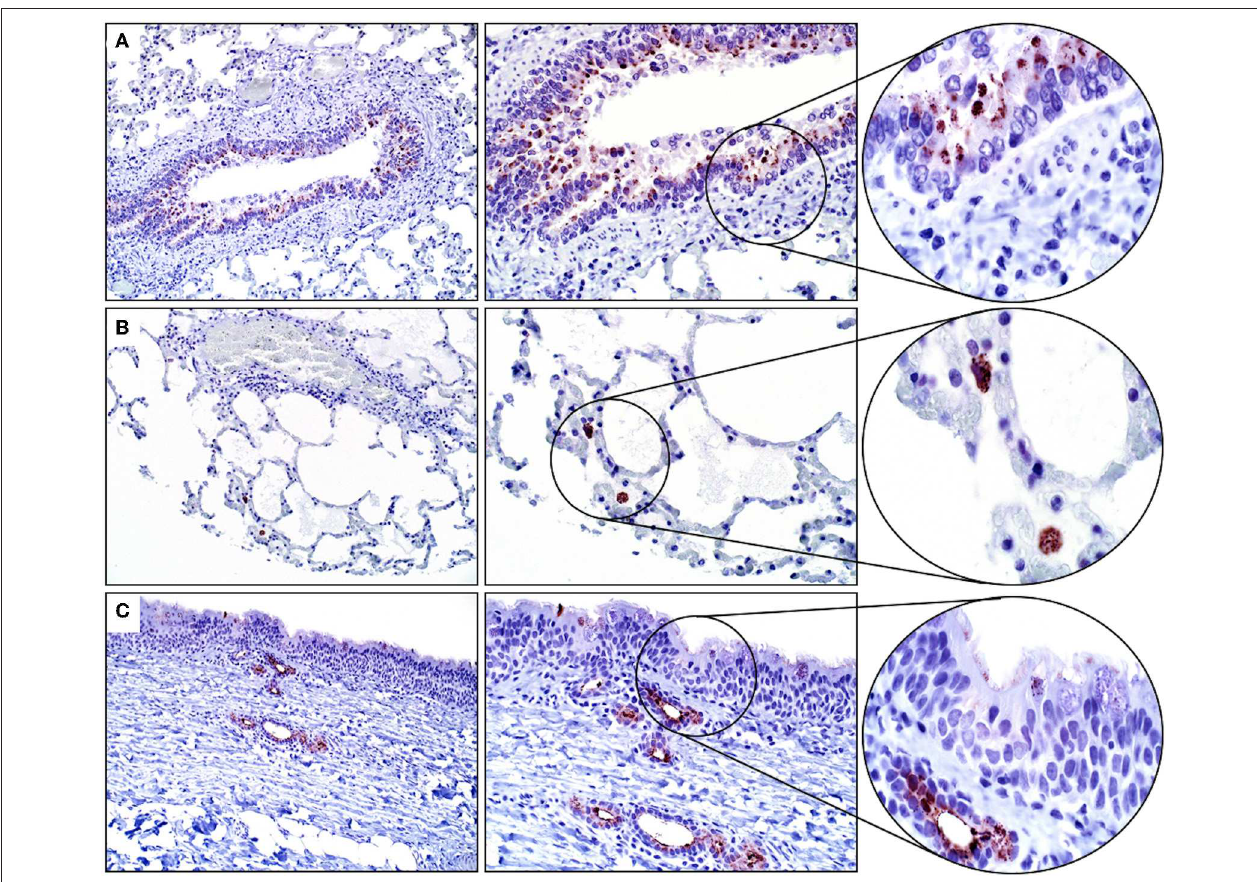
FIGURE 2 | Immunohistochemical detection of SALSA in respiratory tissues. (A) Bronchiolar epithelium stains moderately intense in cytoplasmic, supranuclear, and apical locations. (B) Alveolar macrophages have intense granular cytoplasmic staining. (C) Tracheal mucosal epithelial cells have faint expression, while submucosal glands have moderate cytoplasmic staining; mostly along the luminal surface. Magnification × 200 (left), × 400 (middle), × 1,000